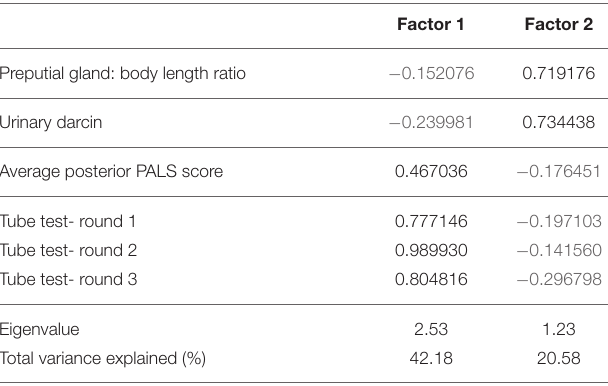
TABLE 3 | Loading values from factor analysis to assess convergent validity of measure